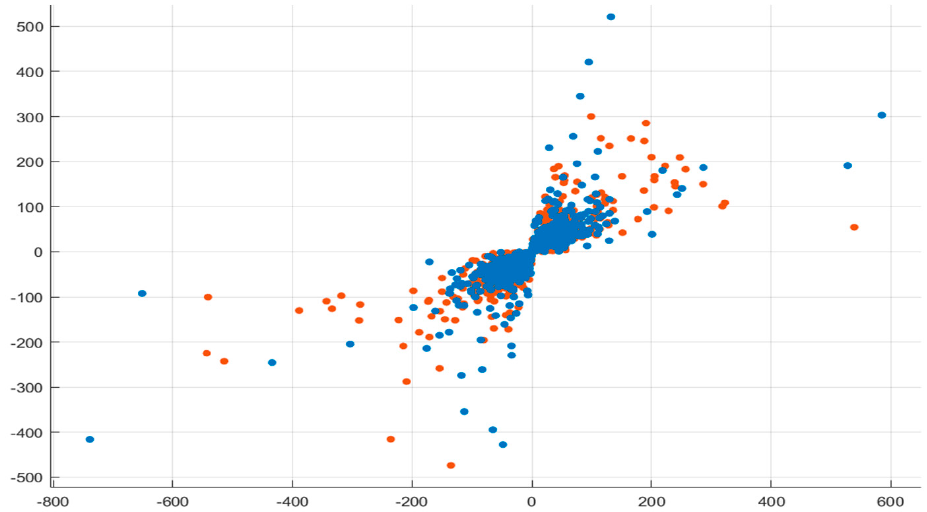
Figure 8. Data distribution of positive and negative emotions. (Blue dots signify negative emotions; red dots signify positive emotions).